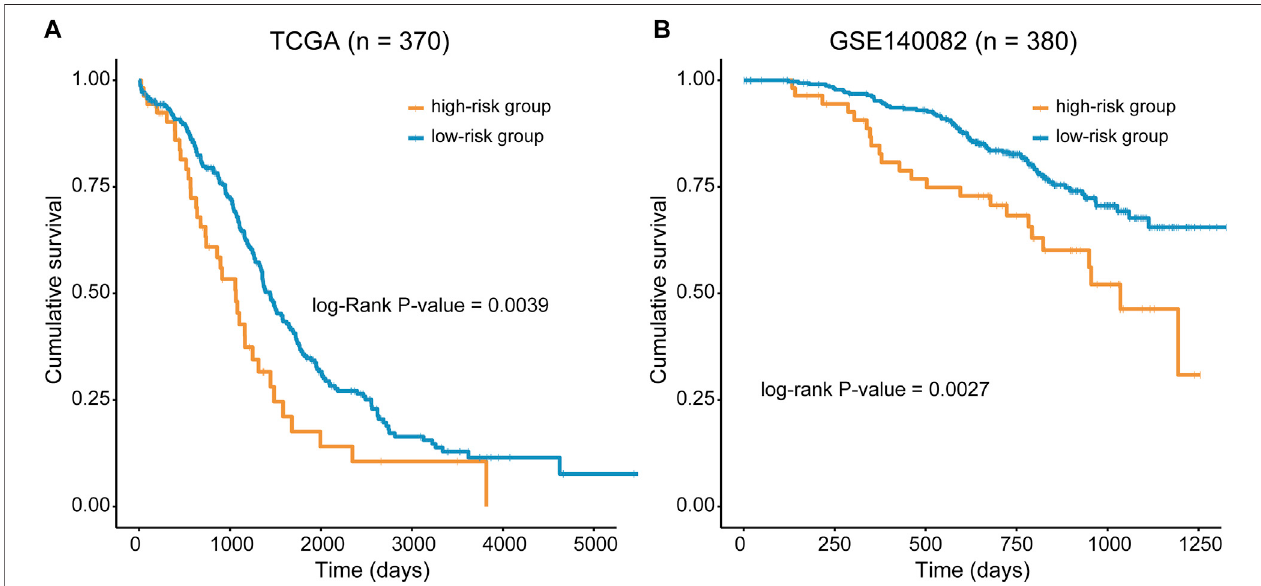
FIGURE 2 | Kaplan – Meier survival curves of OS between the high- and low-risk groups strati fi ed by the RMGS score in TCGA dataset (A) and GSE140082 (B) .